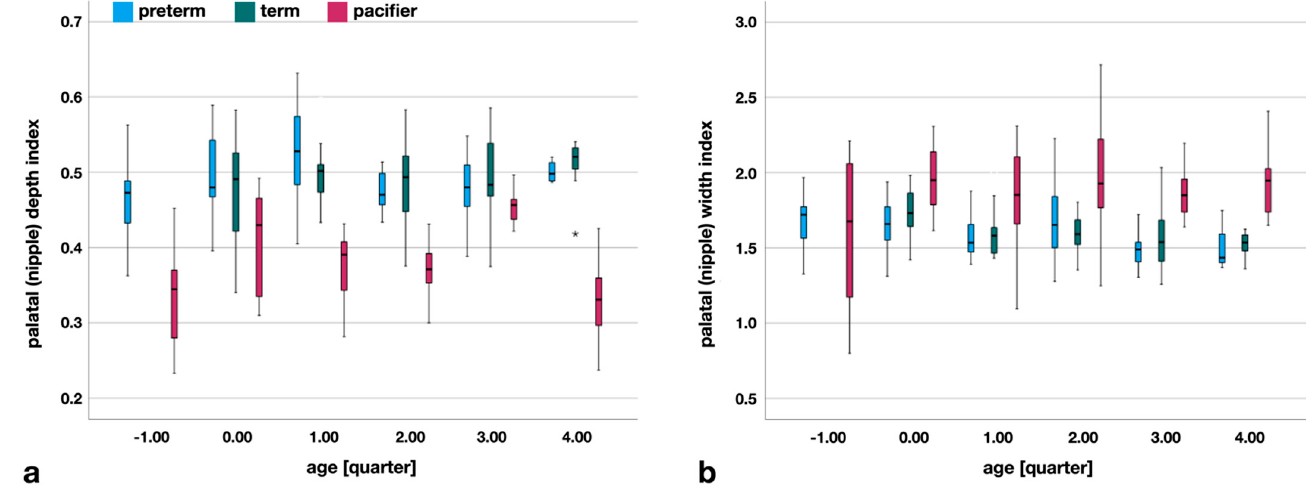
Figure 7. ( a ) Palatal depth index, a dimensionless parameter of the ratio of pd to y-pd , with no meaning for growth. Pacifier scores are significantly smaller than infant scores, except in quarter 3, and are only related to preterm infants. ( b ) Palatal width index as a ratio of pw to y-pw . Here, the pacifier values are significantly larger, except in quarter − 1. (*) extreme outlier.